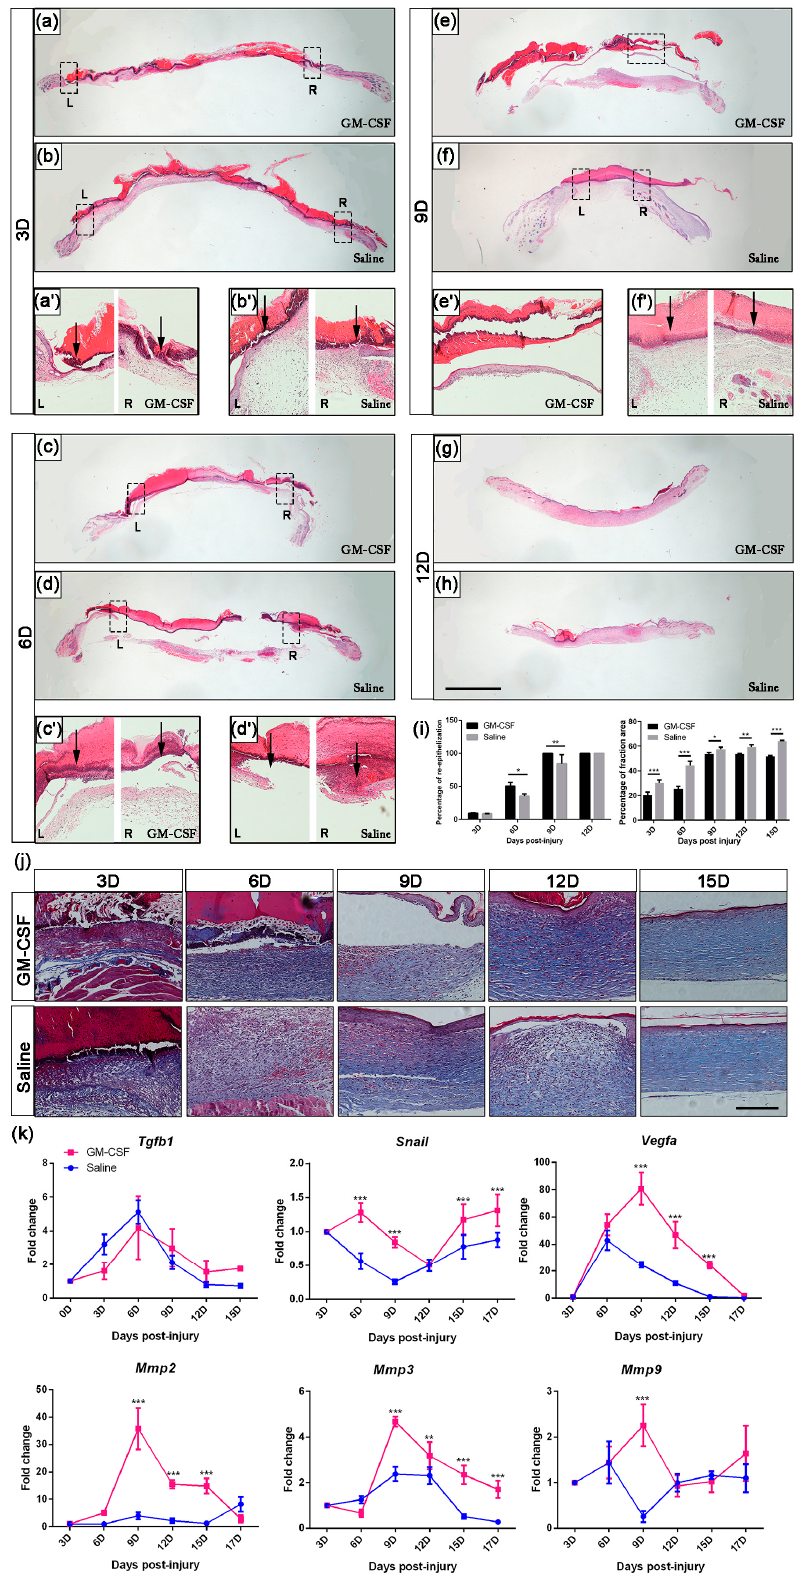
Figure 7. Analysis of the effect of GM-CSF treatment during wound healing process. ( a – h ) Re- epithelialization analysis of GM-CSF- vs. saline-injected mice at 3D, 6D, 9D, 12D, and 15D (scale bar: 2.5 mm). Dashed boxes mark inset showing high-magnification images ( a’ – f’ ). Black arrows indicate